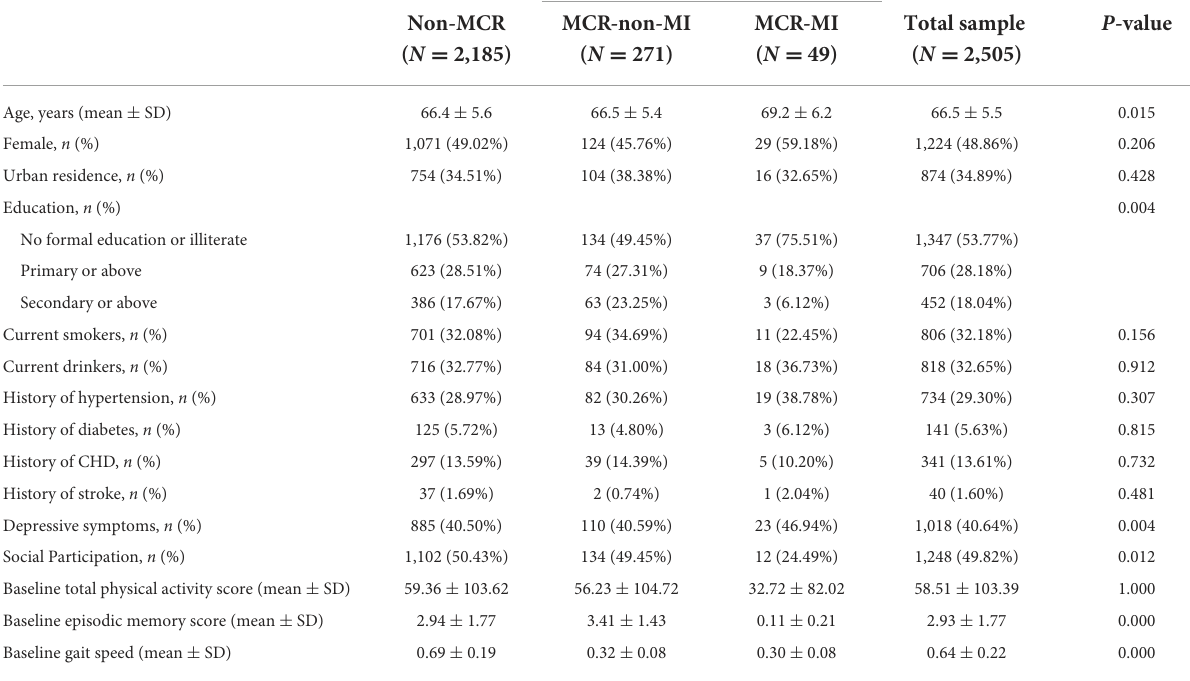
TABLE 2 Characteristics of study participants for IADL disability analysis ( N = 2,505).